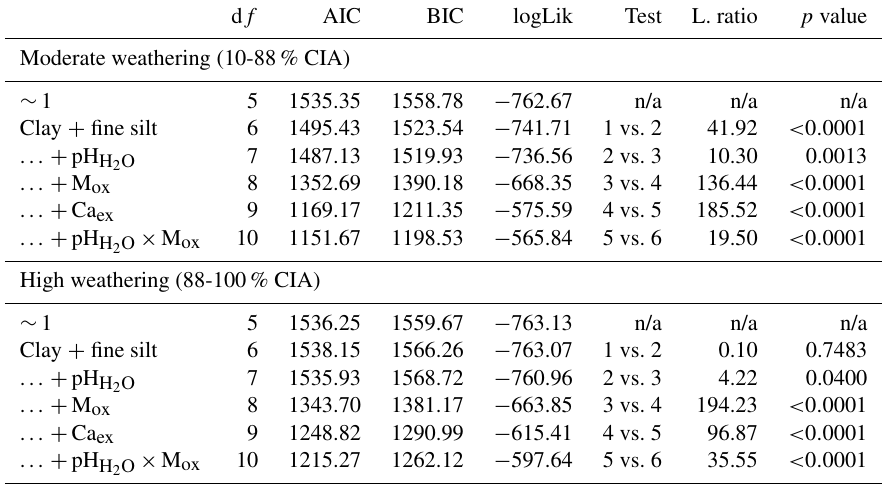
Table B8. ANOVA summary for linear mixed-effects grouped by weathering ( n moderate = 801; n high = 800). Fixed effects were added using a step-wise method. The first entry ( ∼ 1) refers to the constant null model,